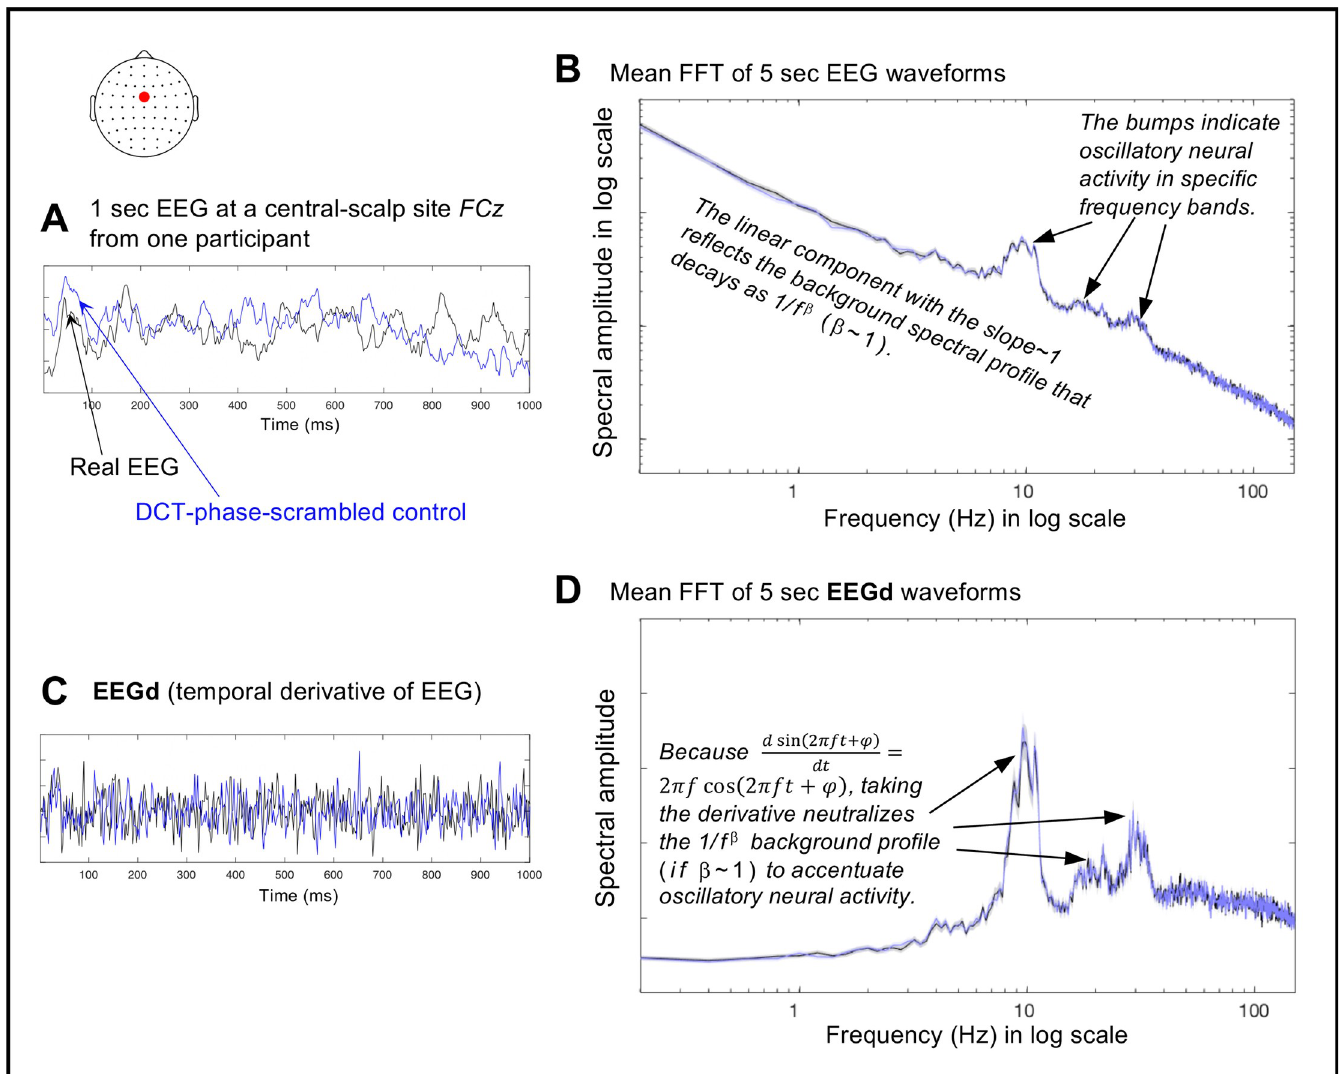
Fig 1. The use of the temporal derivative of EEG (EEGd) and DCT-phase-scrambled controls for investigating the dynamic control of synchronization of oscillatory activity. A. An example of 1 sec EEG waveform (black) and its DCT-phase-scrambled control (blue) at FCz from one participant. B. The mean spectral- amplitude profiles of the full length (~5 min) versions of the same EEG data (black) and its DCT-phase-scrambled control (blue), with the fast Fourier transform (FFT) computed on each consecutive 5 sec waveform and then averaged, plotted in a log-log format. C. The temporal derivatives, which we call EEGd, of the example EEG waveform (black) and its DCT-phase-scrambled control (blue) shown in A. D. The mean spectral-amplitude profiles of the full length (~5 min) versions of the same EEGd data (black) and its DCT-phase-scrambled control (blue), with the fast Fourier transform (FFT) computed on each consecutive 5 sec waveform and then averaged, plotted in a semi-log format. For B and D, the shaded areas represent ± 1 standard error of the mean based on the FFTs computed on multiple 5 sec waveforms. The units are arbitrary (a.u.).